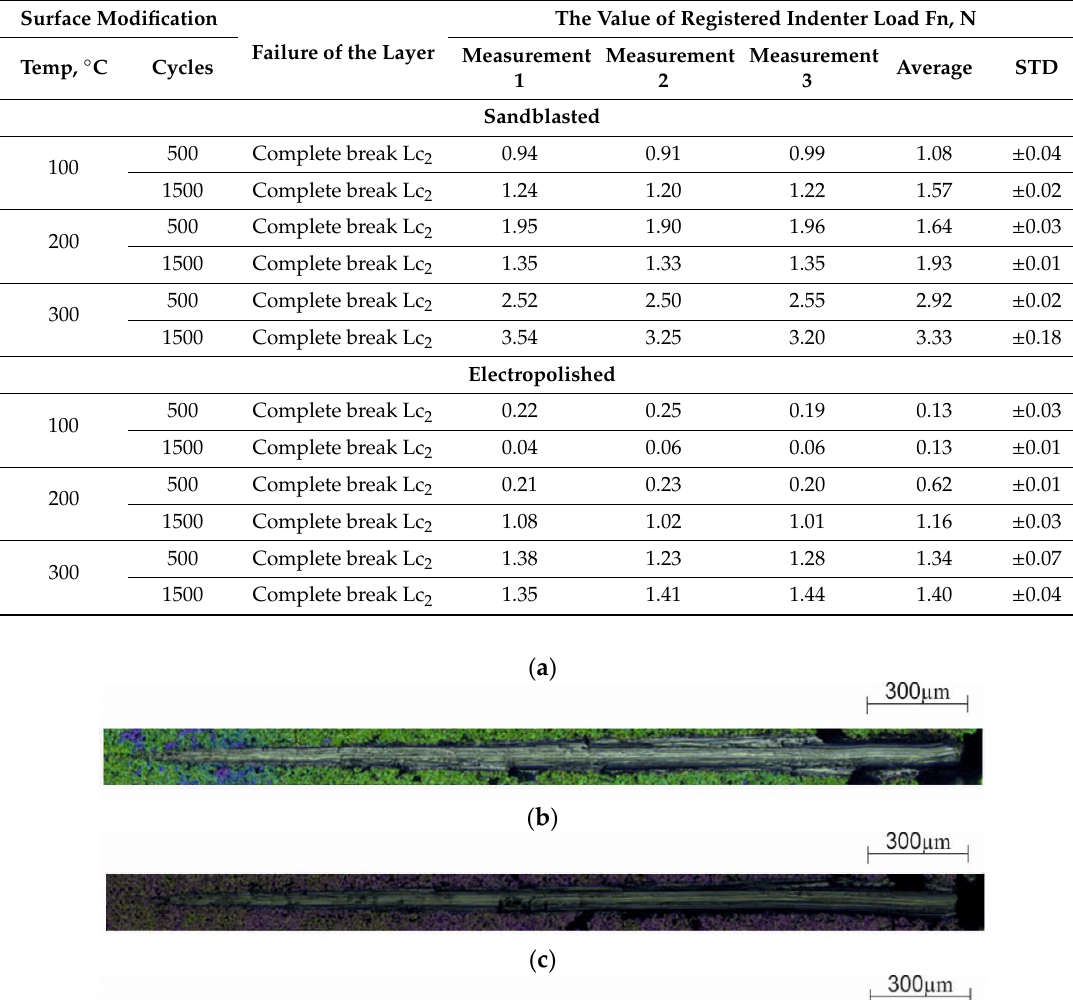
Table 3. The adhesion of the ZnO layer to the substrate made of 316 LVM steel.